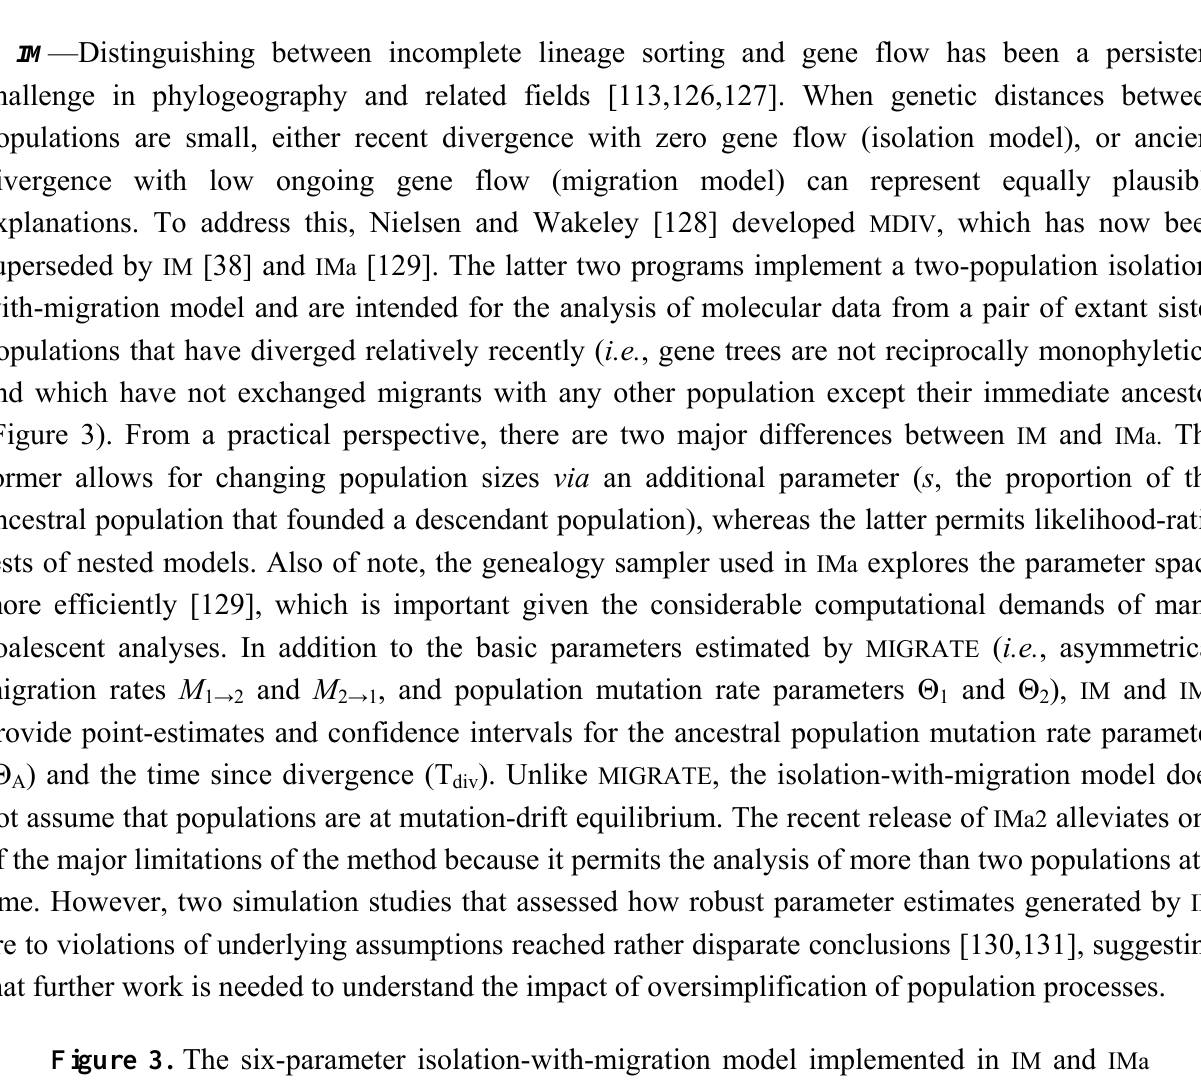
). In IM , an additional div